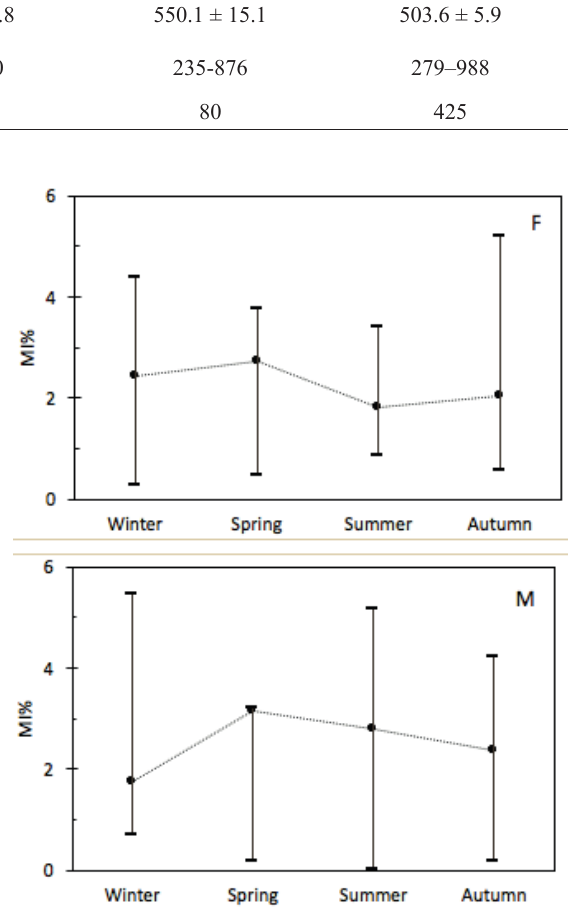
Figure 2 - Marginal increment analysis (MI%, median and range) for females and males of the pink cusk-eel Genypterus